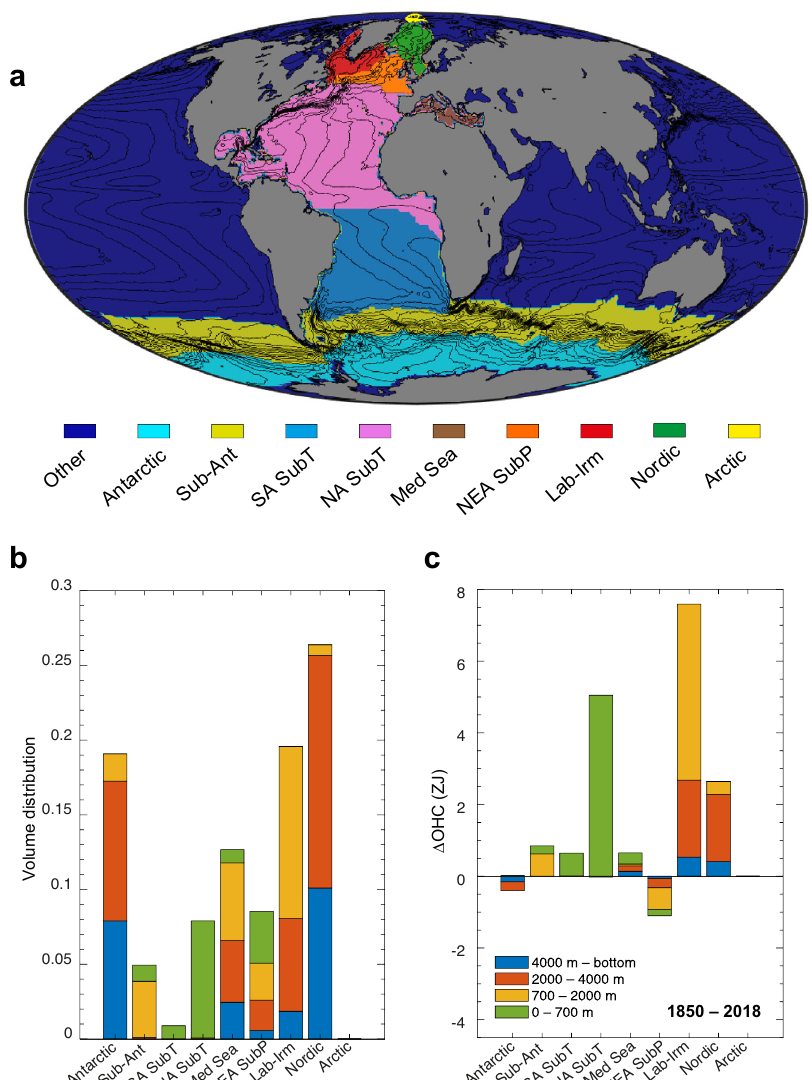
Fig. 3 Source regions and their contributions to volume and Δ OHC at 25°N in 2018. a Map of the main source regions, superimposed on the mean ocean dynamic topography, which displays the main features of the ocean steady-state circulation. Colours delimit the different regions as indicated on the panel. The nine source regions are the western Eurasia Basin (Arctic), the Nordic Seas (Nordic), the Labrador and Irminger Seas (Lab-Irm), the north-eastern subpolar Atlantic (NEA SubP), the Mediterranean Sea (Med Sea), the tropical and subtropical North Atlantic (NA SubT), the tropical and subtropical South Atlantic (SA SubT), the Sub-Antarctic (Sub-Ant) and the Antarctic (Supplementary Note 2). There are no contributions from region Other ( ‘ Methods ’ ). b Regional contributions to the volume at 25°N from the regions indicated in map a. Colours refer to different depth ranges: 0 – 700 m (green), 700 – 2000 m (yellow), 2000 – 4000 m (red), 4000 – bottom (blue). Volumes are normalised to the total volume = 1. c same as ( b ) but for Δ OHC (ZJ) in 2018 relative to 1850. The regional contributions were obtained by summing over all patches of our 5° × 5° gridded world ocean belonging to each of the regions ( ‘ Methods ’ and Supplementary Fig.